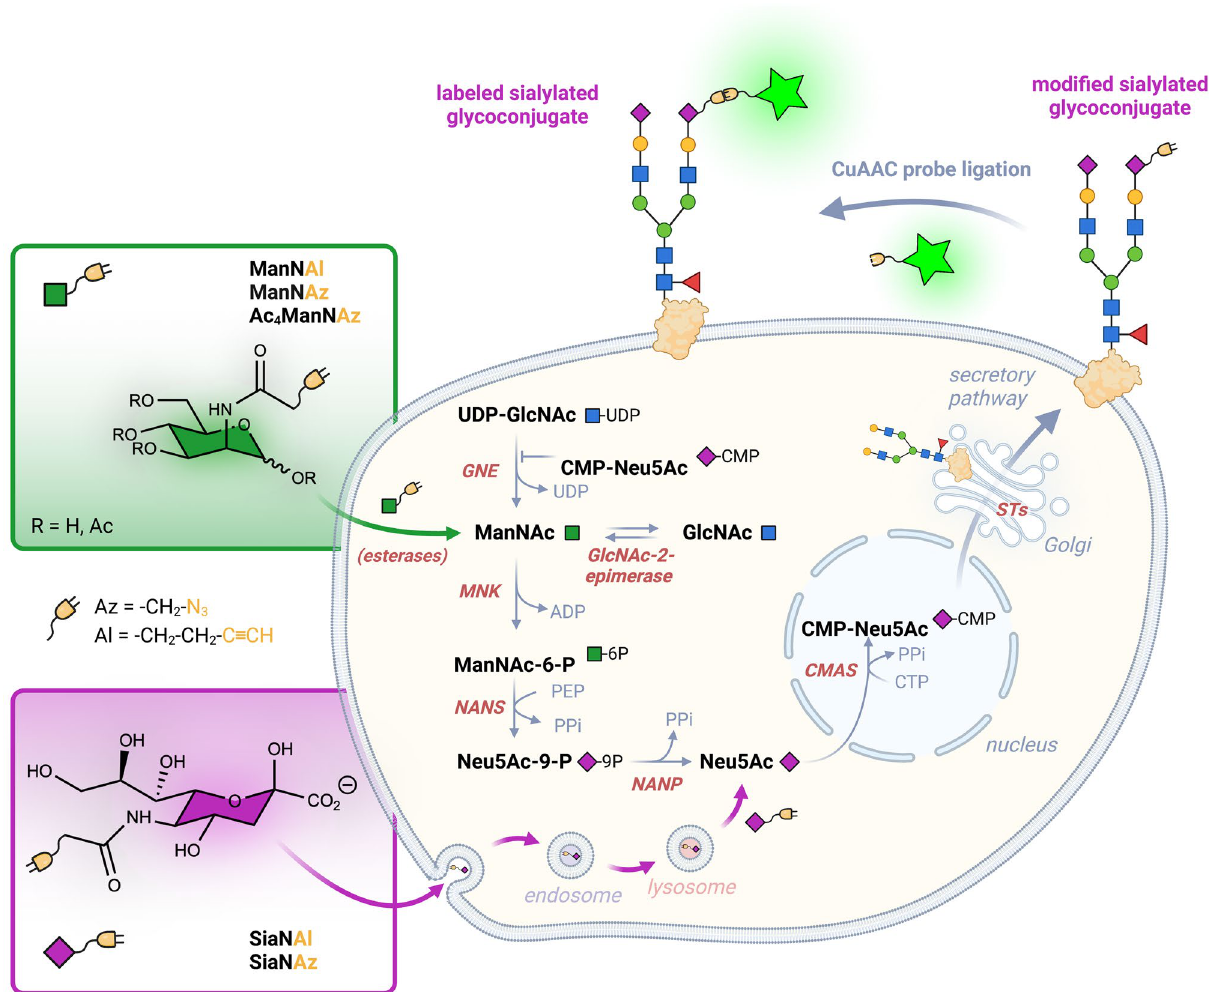
Figure 1. Metabolic incorporation of ManNAc and nonnatural ManNAc and Sia (Neu5Ac) analogs in the sialic acid biosynthetic pathway. ManNAc is synthesized from UDP-GlcNAc and GlcNAc by UDP-GlcNAc 2-epimerase (GNE) and GlcNAc-2-epimerase (RENBP), respectively. ManNAc and ManNAc analogs are phosphorylated by ManNAc 6-kinase (MNK) to yield ManNAc-6-phosphate (ManNAc-6-P). GNE/MNK is a bifunctional enzyme whose GNE activity is inhibited by the final product CMP-NeuAc. The condensation of ManNAc-6-P with phosphoenolpyruvate (PEP) is catalyzed by N -acetylneuraminate synthase (NANS) to produce N -acetyl neuraminic acid-9-phosphate (Neu5Ac-9-P), which is then dephosphorylated by sialic acid phosphatase (NANP) to yield Neu5Ac. Cytosolic pool of Neu5Ac can also be provided by the salvage pathway through endocytosis of free sialic acid and lysosomal recycling. Transport of Neu5Ac to the nucleus enables CMP-sialic acid synthetase (CMAS) to produce CMP-NeuAc. After its transport into the Golgi apparatus, CMP-NeuAc is utilized by the sialyltransferases (STs) for the terminal glycosylation of glycoconjugates that are ultimately secreted or destined for the cell surface or organelles, as illustrated here with a transmembrane N